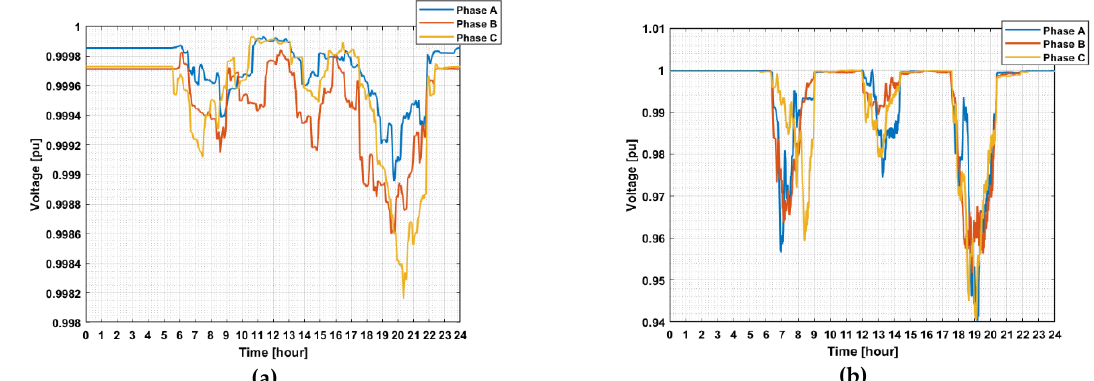
Figure 9. ( a ) The three-phase voltage profile at busbar_1 before adding 100% eCook; ( b ) The three-phase voltage profile at busbar_1 after adding 100% eCook.